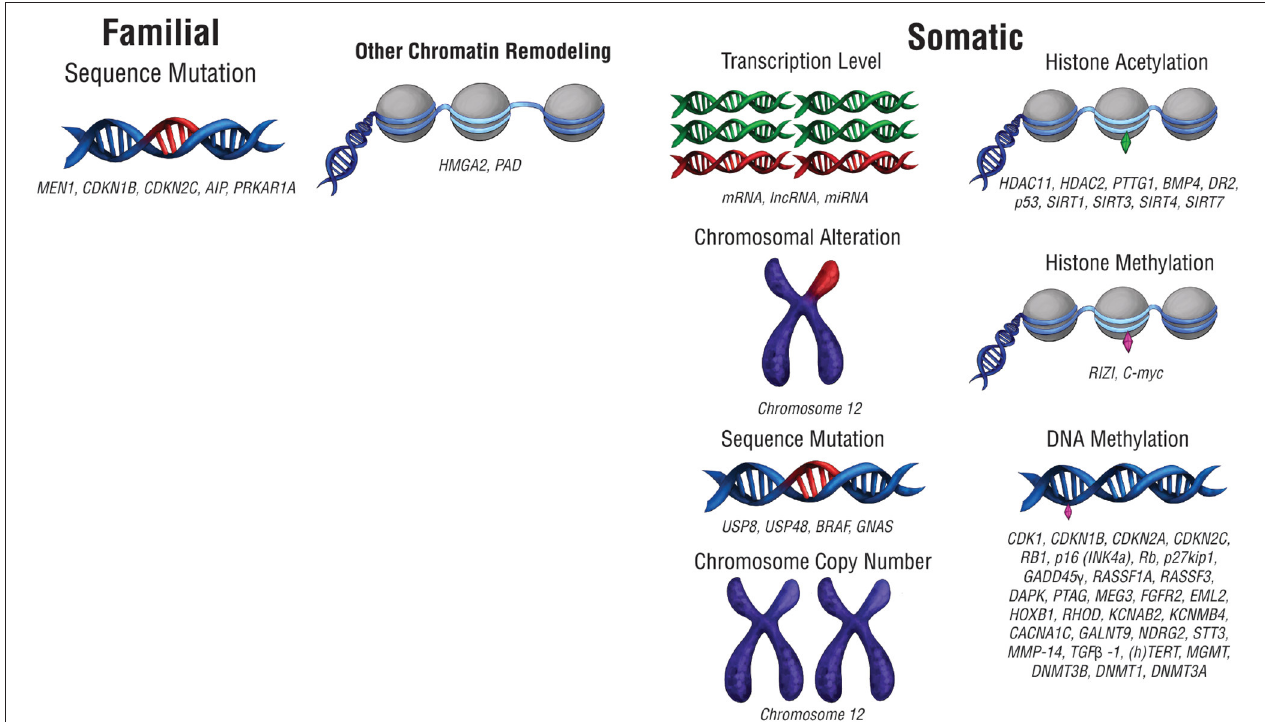
FIGURE 1 | Pre-translational modifications that affect gene expression. Modifications that affect gene expression can occur at any point along the path from packaged DNA to protein expression. Alterations to chromosome structure or changes in chromosome copy number can affect expression at a chromosomal level. Epigenetic chromatin modifications, including histone acetylation and histone methylation, can also alter gene expression levels. At the DNA level, mutations in DNA sequence or DNA methylation can change the nature of the genes expressed as well as their level of expression. RNA transcript copy number also affects protein expression.